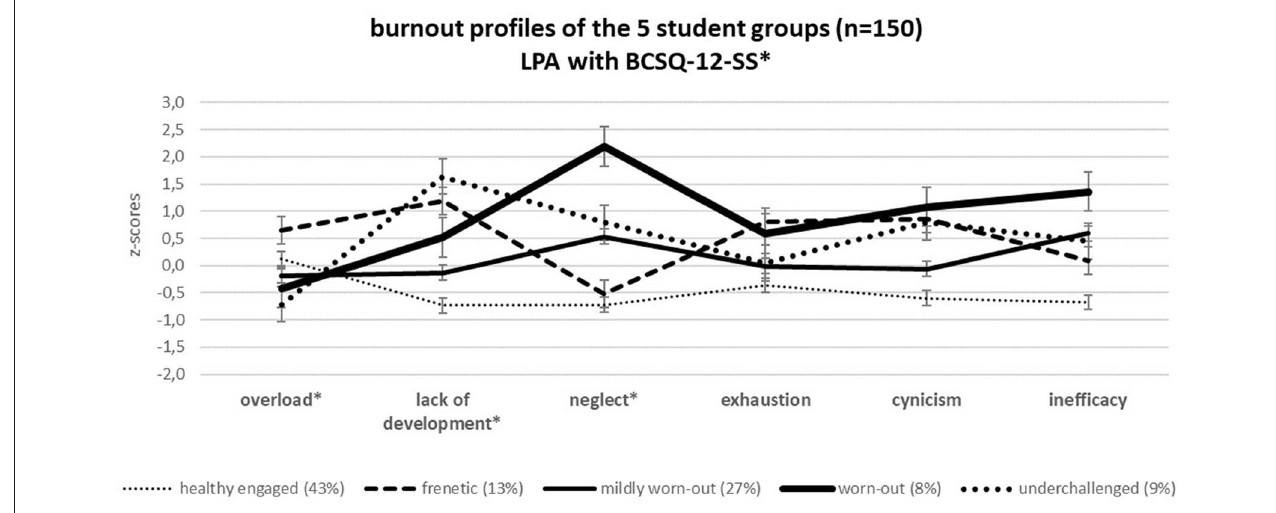
FIGURE 3 | Burnout characteristics of the five BCSQ-12-SS classes in the stressed subsample.